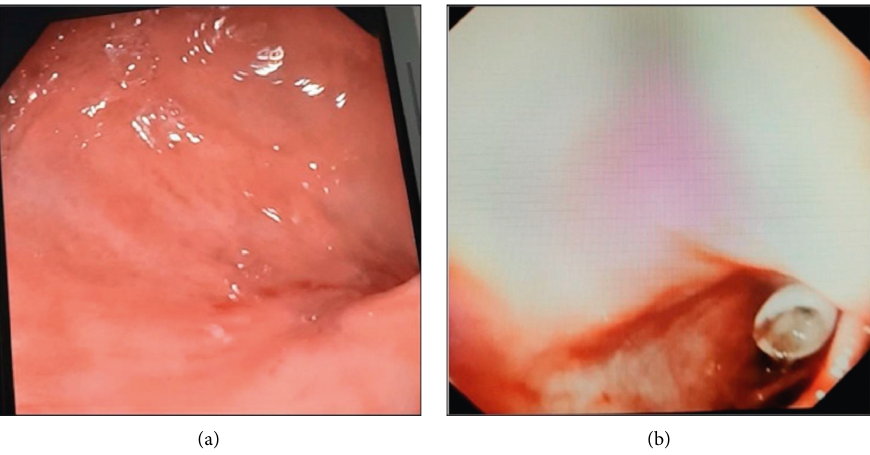
Figure 2: (a) Gastric view of endoscopic exam; no gastrostomy bumper was visualized in the stomach; the gastric wall was intact. (b) In colonoscopy, the gastrostomy bumper was visualized at the level of the right colonic